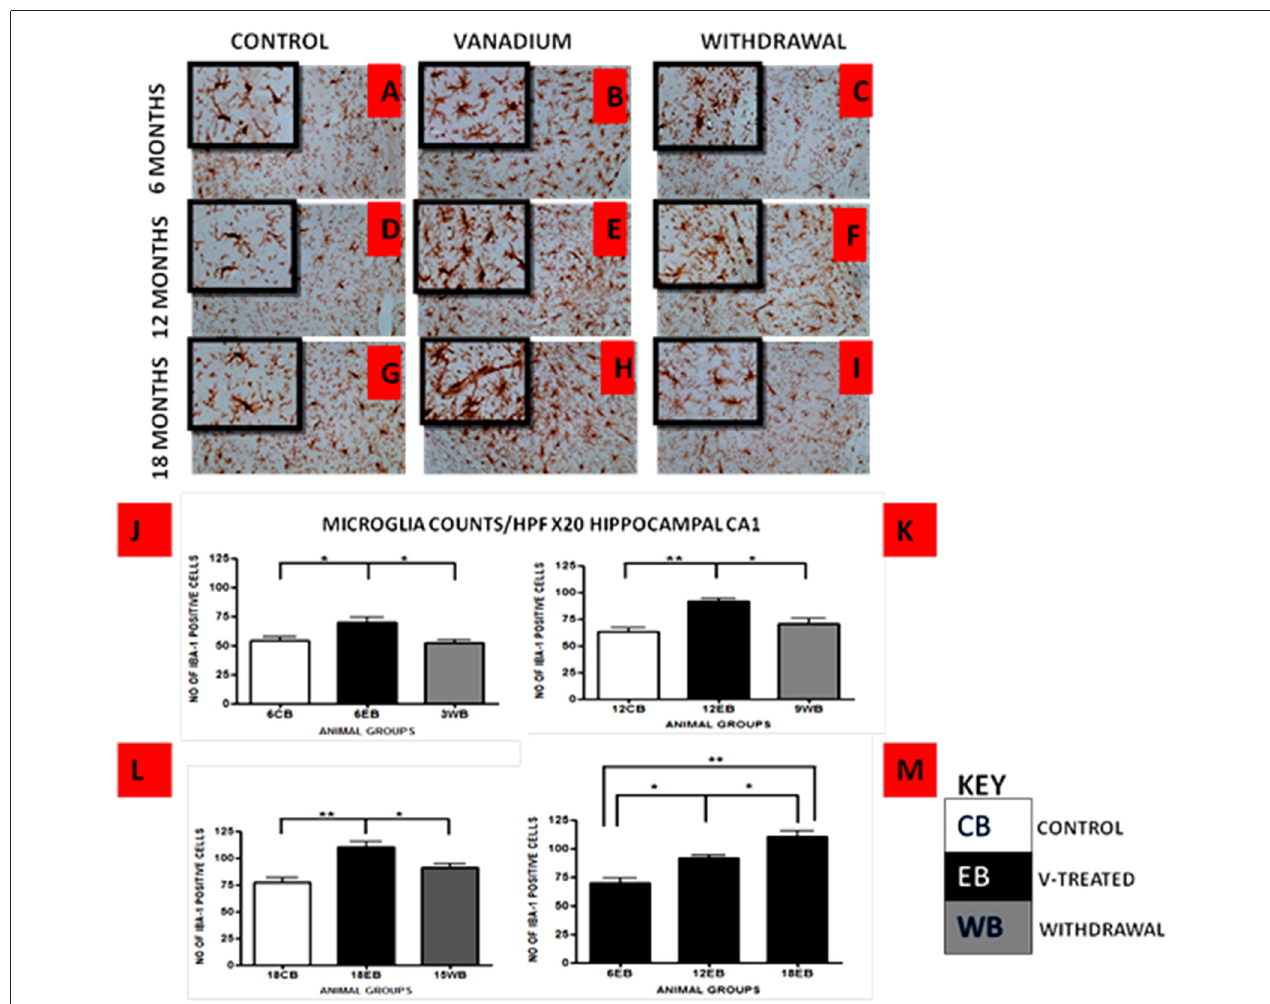
FIGURE 4 | IBA-1 immunostained dorsal CA1 hippocampal region of vanadium exposed (B,E,H) , age matched control (A,D,G) and withdrawal group (C,F,I) mice after intermittent vanadium treatments for 6, 12 and 18 months revealed microglial activation identified by an enlarged cell body with several short, thickened processes, relative to the matched controls with longer, finer branches while the withdrawal groups showed better morphology relative to vanadium exposed groups. Figure 5 (J–L) , the number of IBA-1 positive cells in hippocampal CA1 region, were significantly increased in all the vanadium exposed groups compared to control, while the withdrawal groups showed reversal effect. Microglia activation increases into advanced age with increasing vanadium exposure ( M ; 6EB vs. 18EB = ∗∗ p < 0.01), (ANOVA: ∗ p < 0.05, ∗∗ p < 0.01). Magnification: × 200 inset: ×